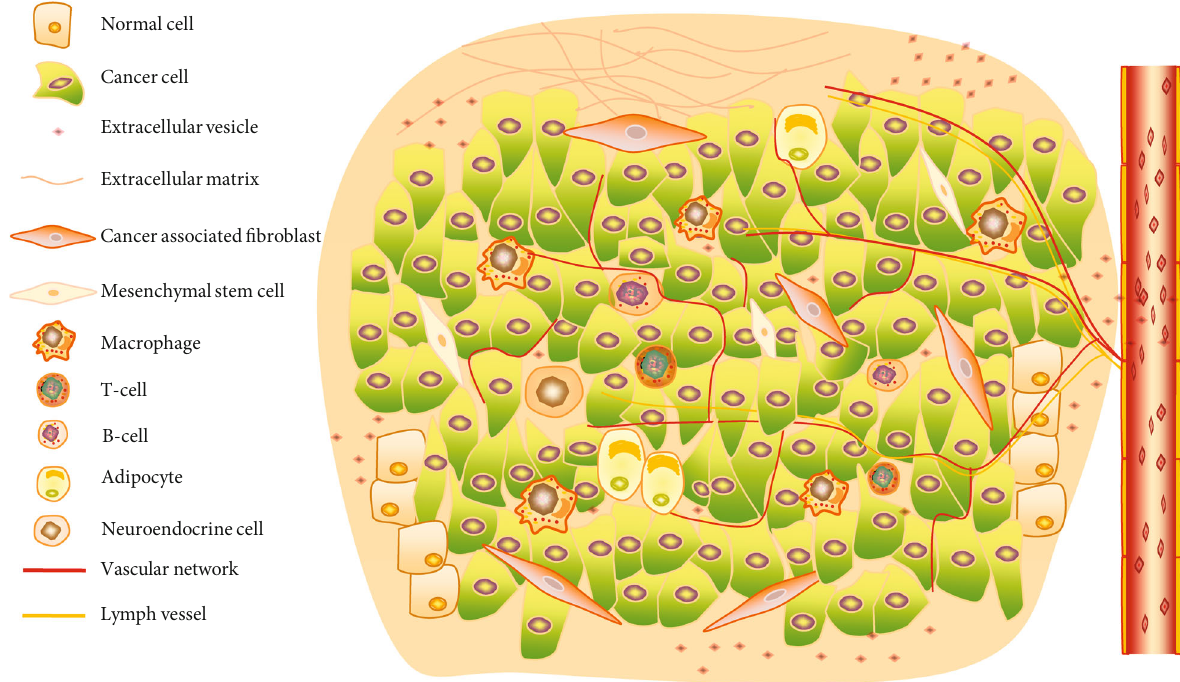
Figure 1: Complex components of the TME. The scheme indicates multiple cellular and other noncellular parts form the web of the TME